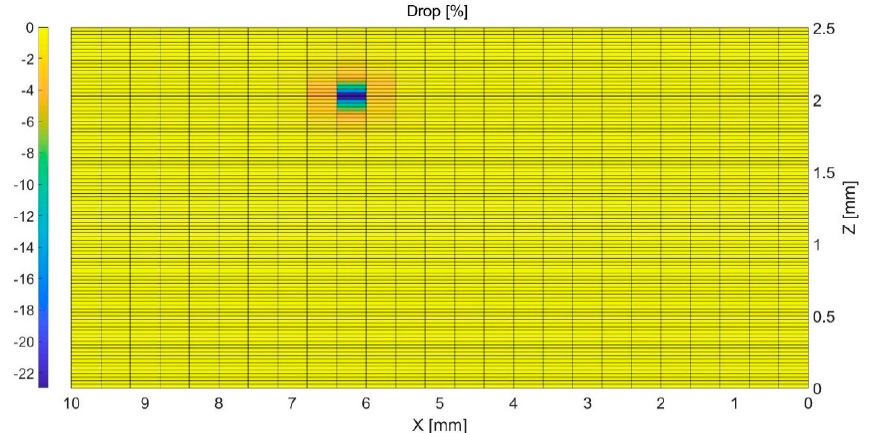
Figure 11. 2D plot of the drop at the XZ plane for crack1 (100 μ m).